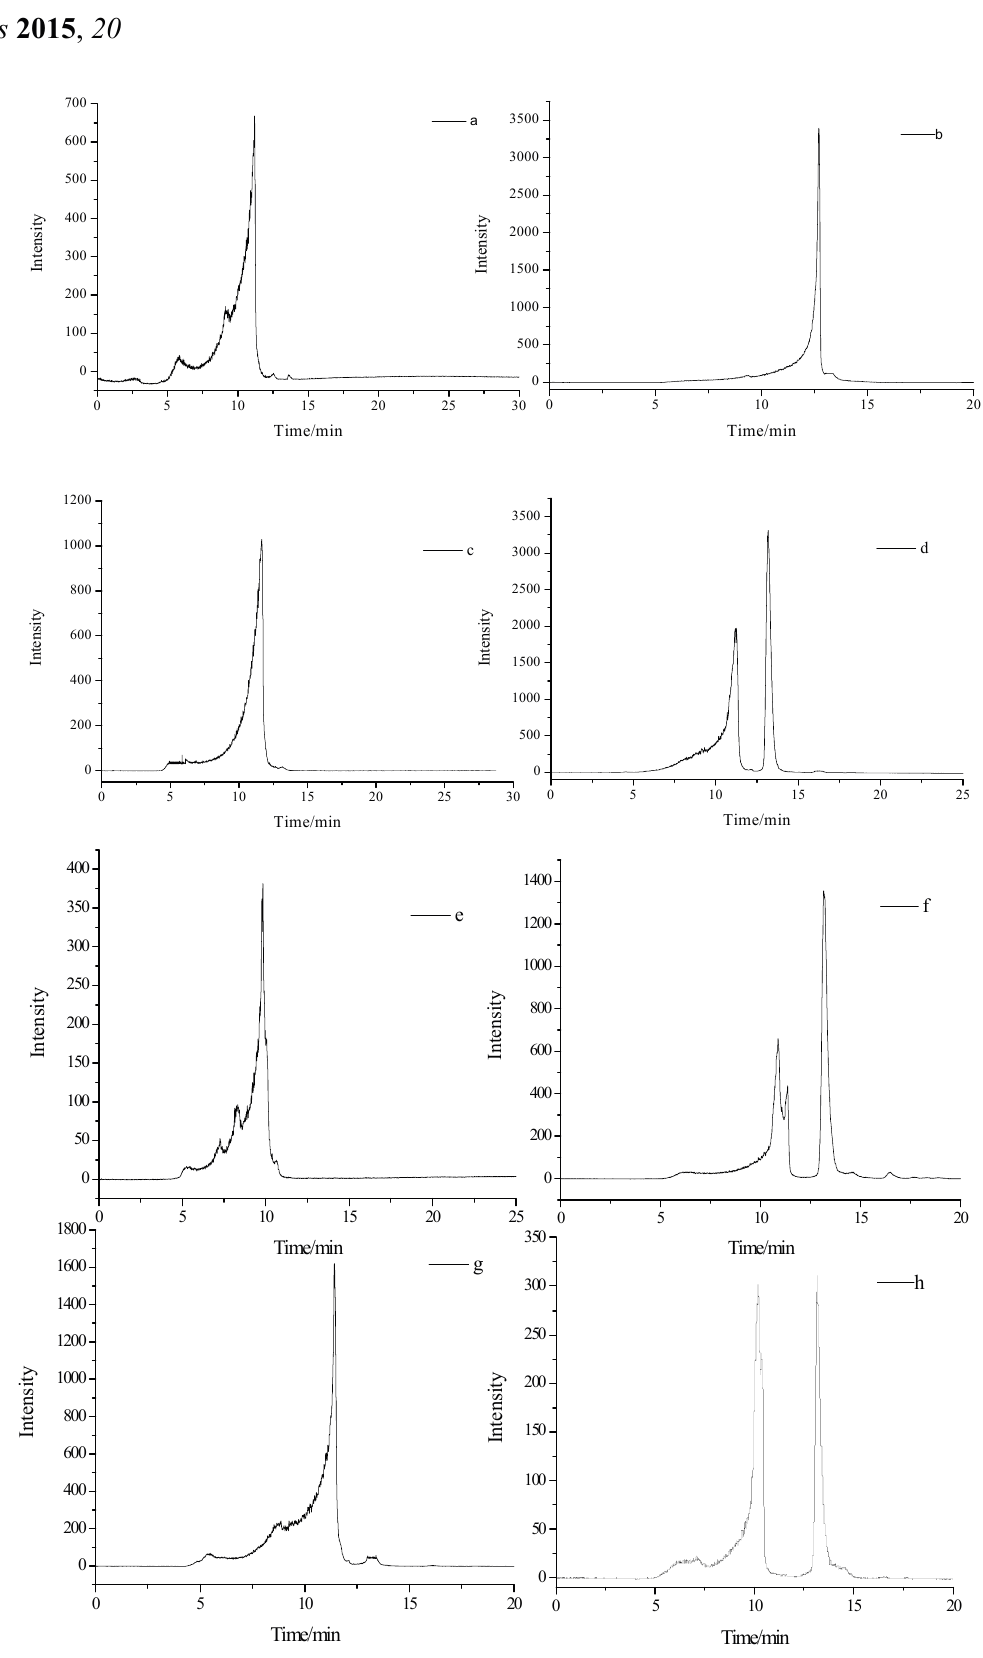
Figure 5. GP-HPLC of PBLPS from the four varieties of bamboo leave: PBLPS: Purified BLPS. ( a , b ) from Phyllostachys nigra (PN); ( c , d ) from Phyllostachys vivax (PV); ( e , f ) from Chimonobambusa quadrangularis (Fenzi) Makino (CQ); ( g , h ) from Phyllostachys bambusoides